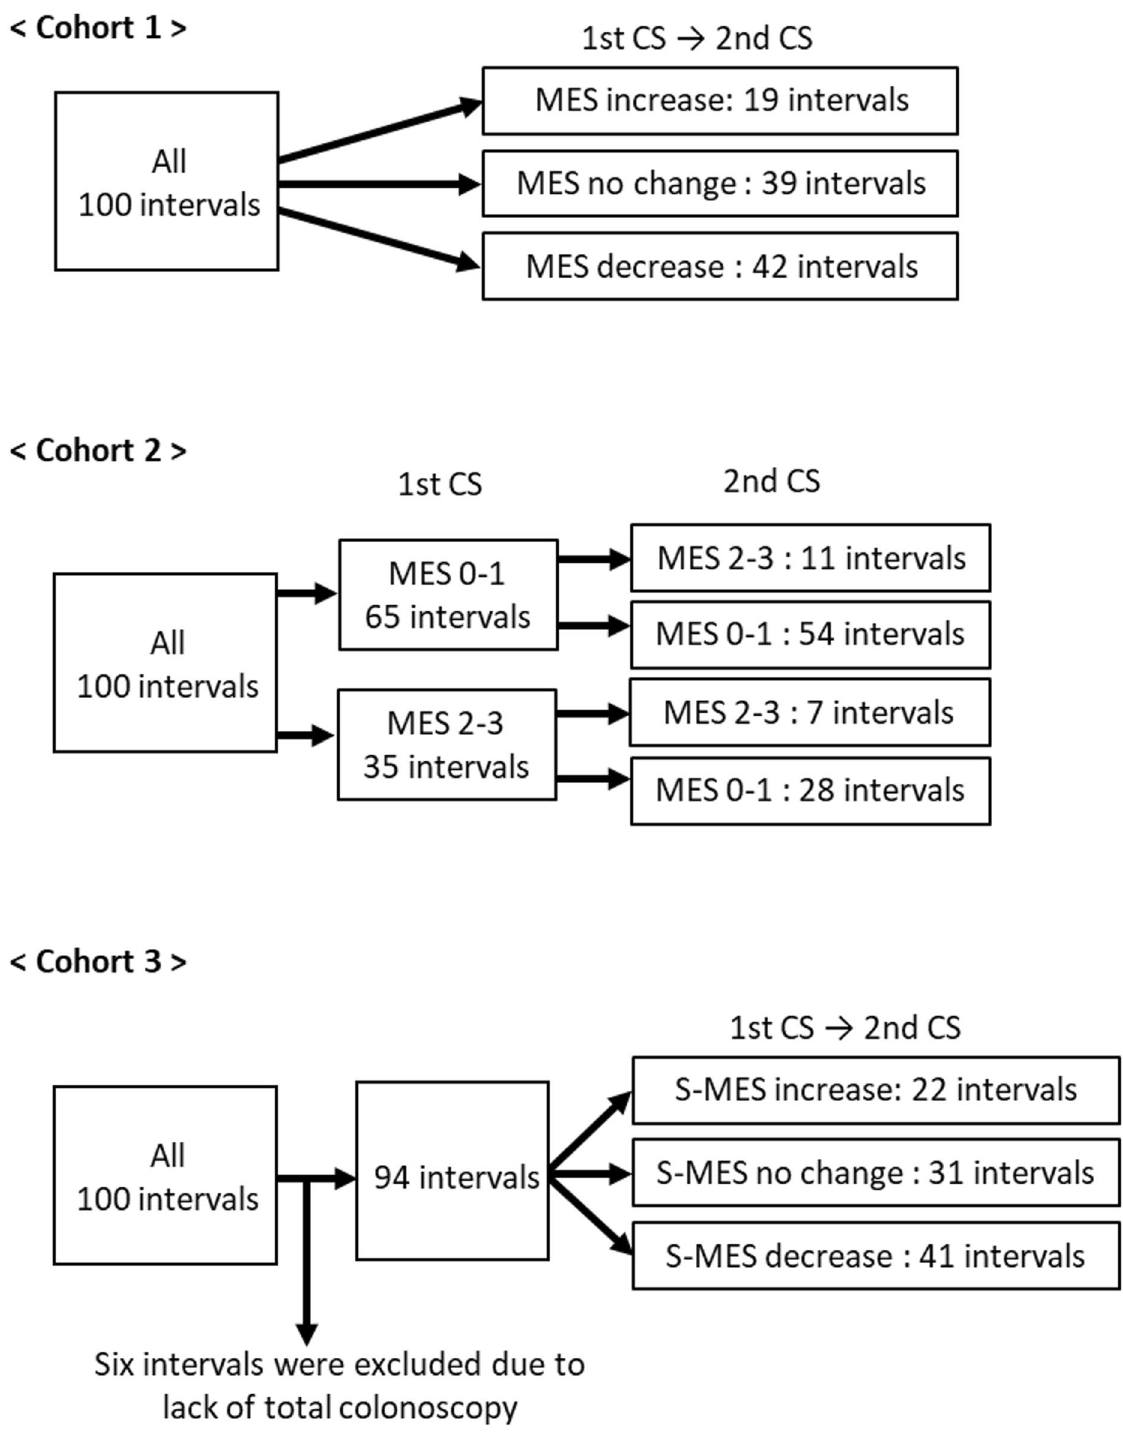
Figure 5. Study flow diagram. Three cohorts in the present study were divided as shown. In Cohort 1, 100 intervals were grouped as Mayo endoscopic subscore (MES) increase, no change, and decrease. In Cohort 2, groups of MES 0 or 1 and 2 or 3 were further subdivided as shown in the figure. In Cohort 3, 6 patients were excluded and the remaining 94 were grouped as sums of MES (S-MES) increase, no change, and